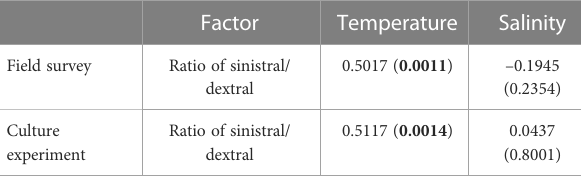
TABLE 2 Correlations (Pearson ’ s r values) between the ratio of sinistral/ dextral and environmental